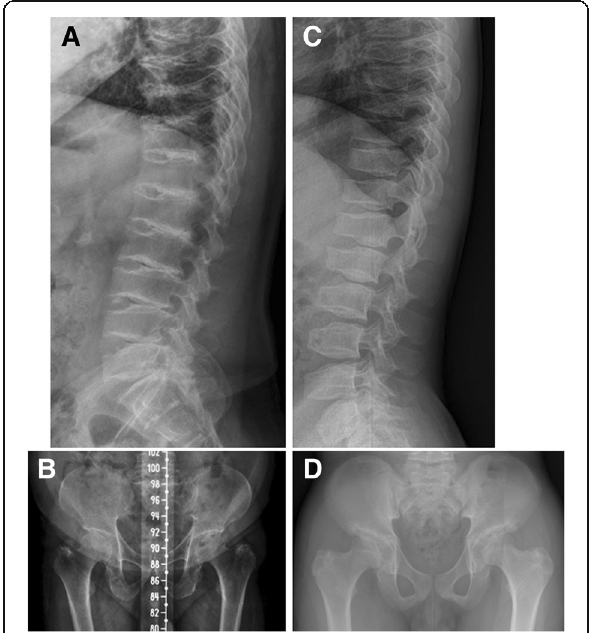
Fig. 1 Lateral spine and hip radiographs of two SEDT-XL patients. a , b Radiographs taken from the proband with the c.1A > T, TRAPPC2 variant at age of 45 years. a Thoracolumbar lateral spine shows uniform platyspondyly and hump-like bony projections at the centroposterior portions of upper and lower endplates, and narrowing or almost obliteration of the intervertebral disc spaces. b Pelvis radiograph shows narrow iliac wings with relatively long ischium and pubic bones, deep acetabulum and degenerative osteoarthtis with narrow hip joints. c , d Radiographs from the proband with the c.40delG, TRAPPC2 variant at age 15 years. c Spine lateral radiograph shows platyspondyly with elongated vertebral bodies and hump-like bony protrusion at the upper and lower endplates, dominantly noted in the lumbar spine. d Hip shows relatively long ischium and pubic bones. Deep acetabulum and dysplastic femoral heads with premature degenerative hip joint narrowing are